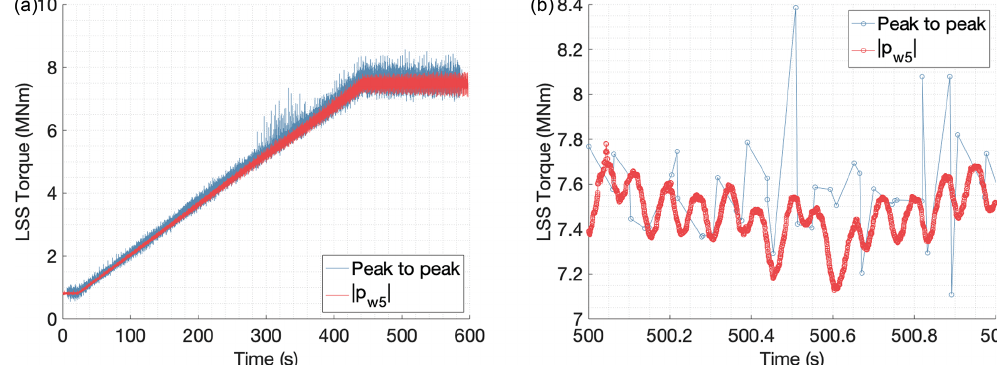
Figure 19. Torque estimates for a test with variable torque (ramp); results for the entire test in panel (a) and 1s detail in panel (b) .